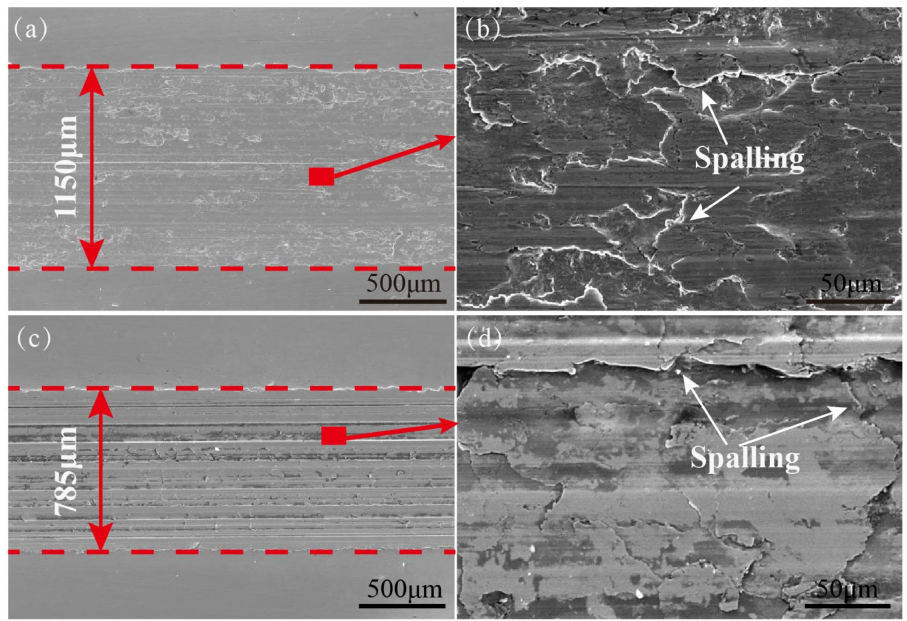
Figure 9. SEM images of worn plates (0#, 100 ◦ C): ( a , b ) PAO4; ( c , d ) PAO4 + DS.